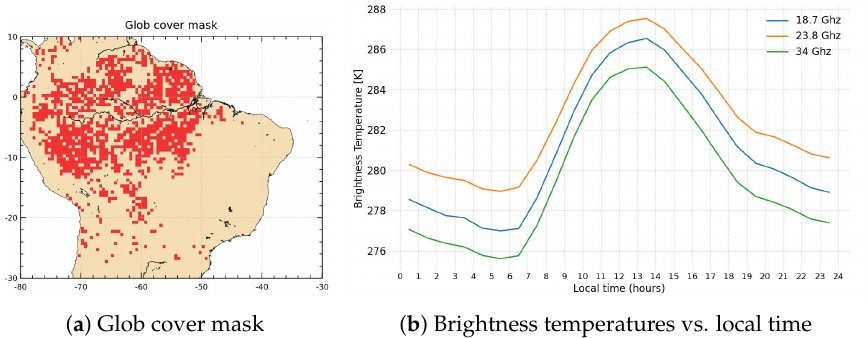
Figure 8. ( a ) Glob cover mask and ( b ) variation of Jason-2 brightness temperatures measurements averaged in one hour bins of local